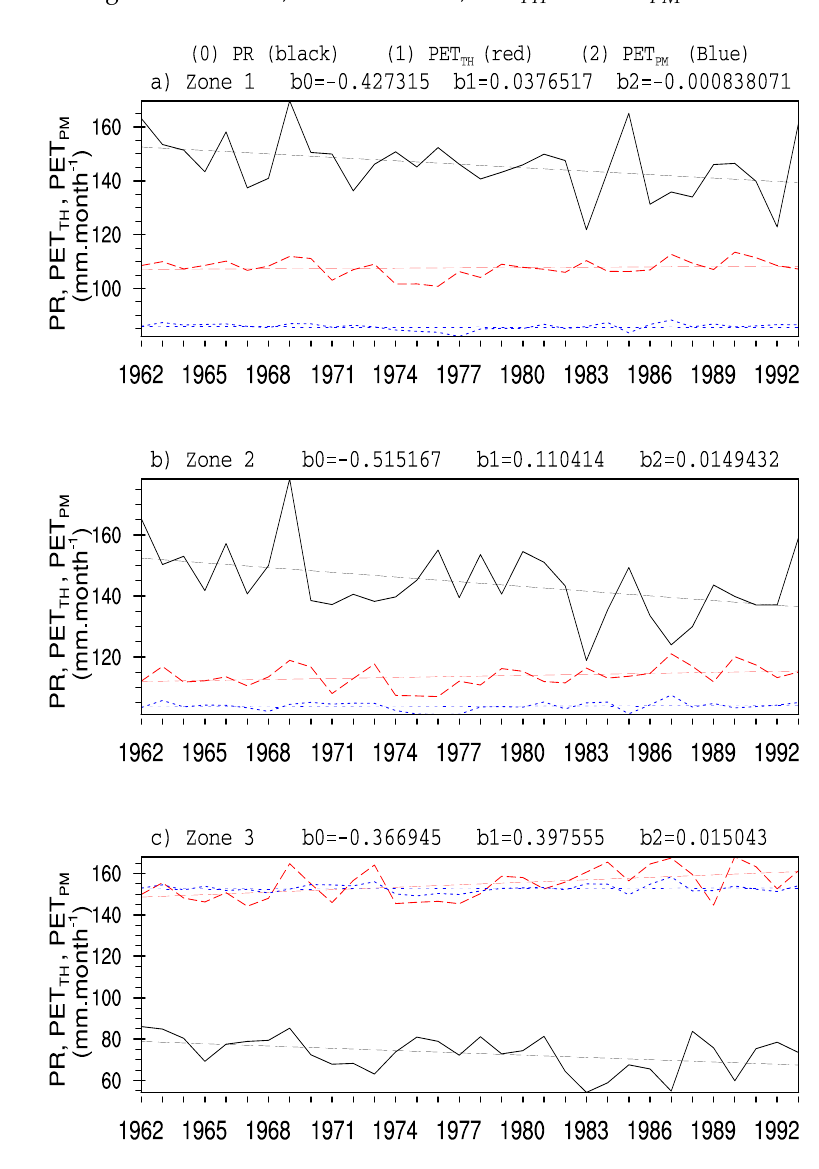
Figure 9. Time series of mean monthly PR, PET TH and PET PM per zone (expressed in mm · month − 1 ): ( a ) for the Equatorial forest zone named Zone 1 (south of study area); ( b ) for the transition zone between the Equatorial forest zone and the Sahel zone named Zone 2; and ( c ) for the Sahelian zone named Zone 3 (north of study area). The regression lines are shaded and trend coefficients indicated by b0, b1 and b2 for PR, PET TH and PET PM ,